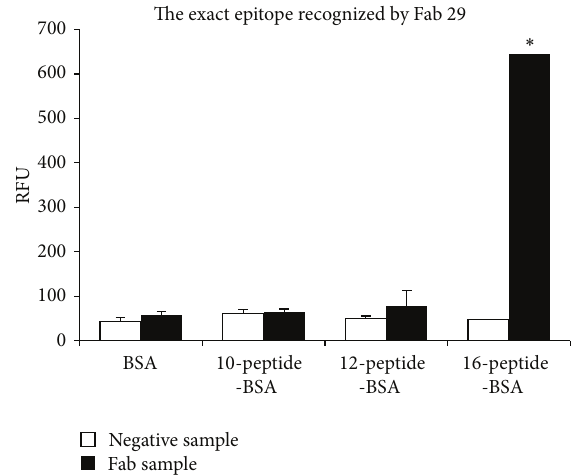
Figure 10: Identification of the exact epitope recognized by the anti- P-gp Fab by indirect immunofluorescence.